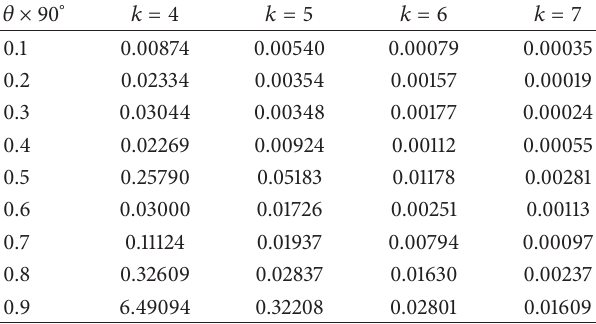
Table 1: The absolute errors between original RCS and reproduced RCS for different 𝑘 (dB).